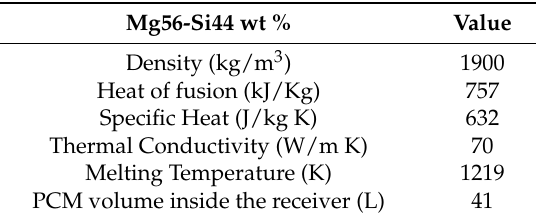
Table 3. Selected Phase Change Material properties.